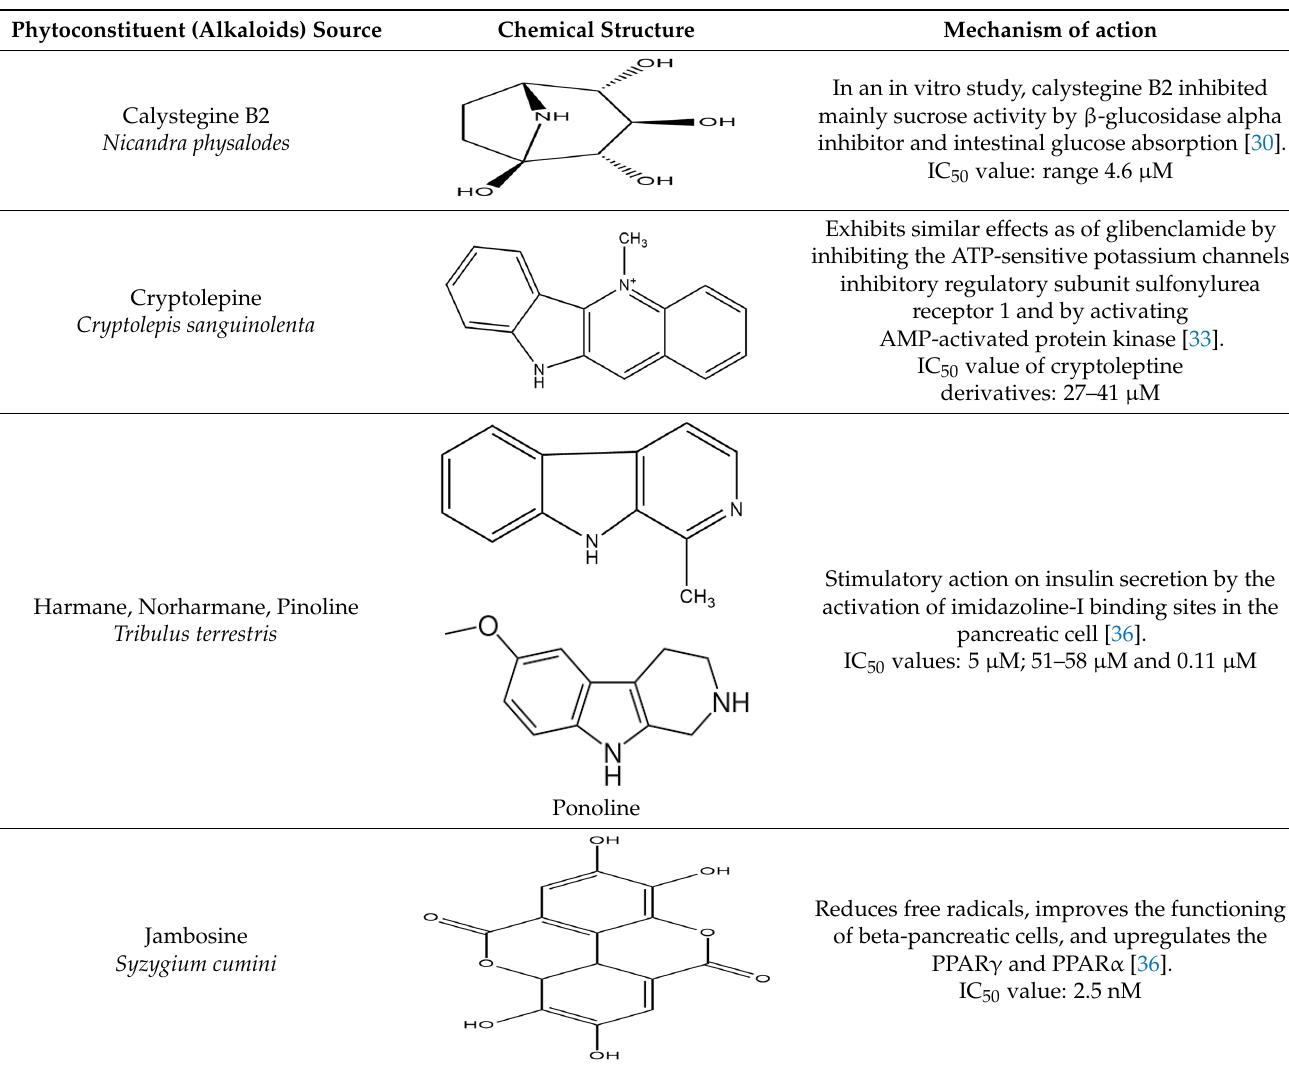
Ponoline Ponoline